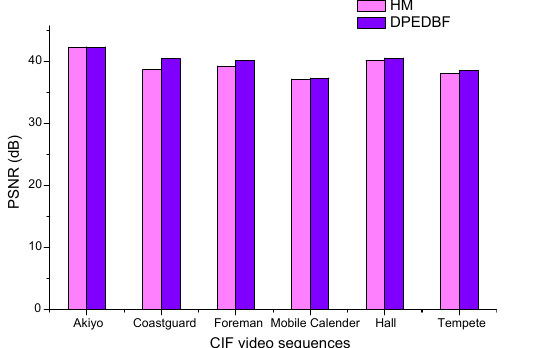
Figure 26. Comparison of PSNR with HM for CIF video sequences using QP =